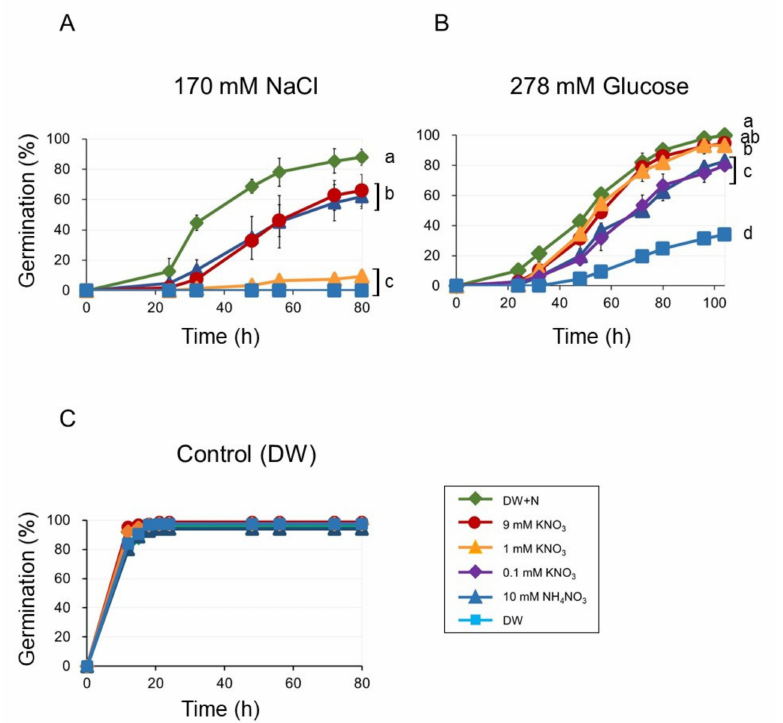
Figure 3. Seed germination on KNO 3 or NH 4 NO 3 medium (DW, DW + N, 9 mM KNO 3 , 10 mM NH 4 NO 3 , 1 mM KNO 3 and 0.1 mM KNO 3 ) in the presence of inhibitory compounds ( A ) 170 mM NaCl, ( B ) 278 mM glucose, and ( C ) controls (no inhibitory compounds). Seeds were stratified for three days before incubation at 23 ◦ C. Germination was scored after transferred to 23 ◦ C. Data are means ± SD of three replicates. Each replicate contained 50 seeds. Di ff erent letters indicate significant di ff erences in germination the final time point (ANOVA and Tukey’s test, p <